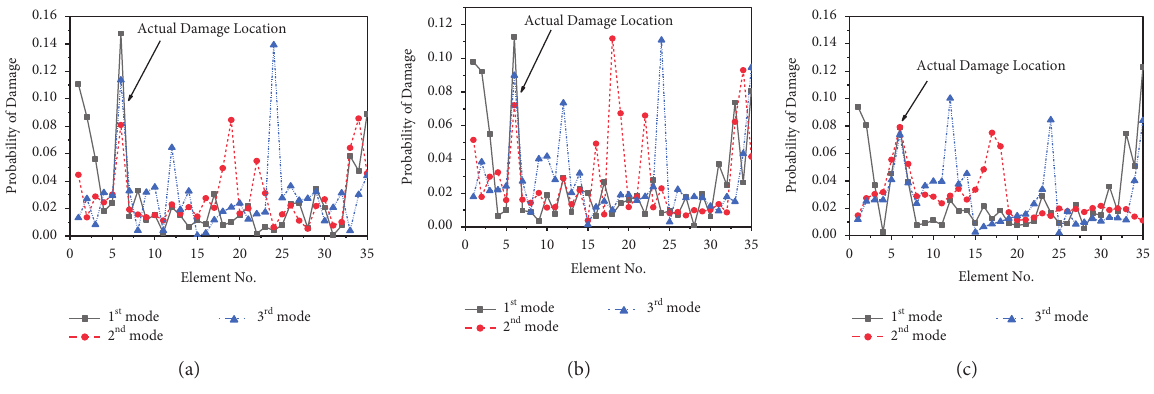
Figure 31: Damage identification results of form 2 for DR (a), CR (b), and RD (c).